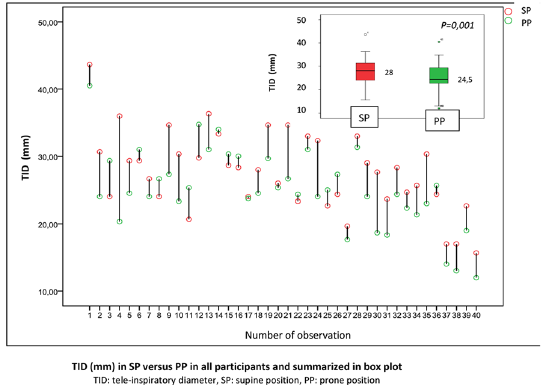
Fig. 1 TID (mm) in SP versus PP in all participants and summarized in box